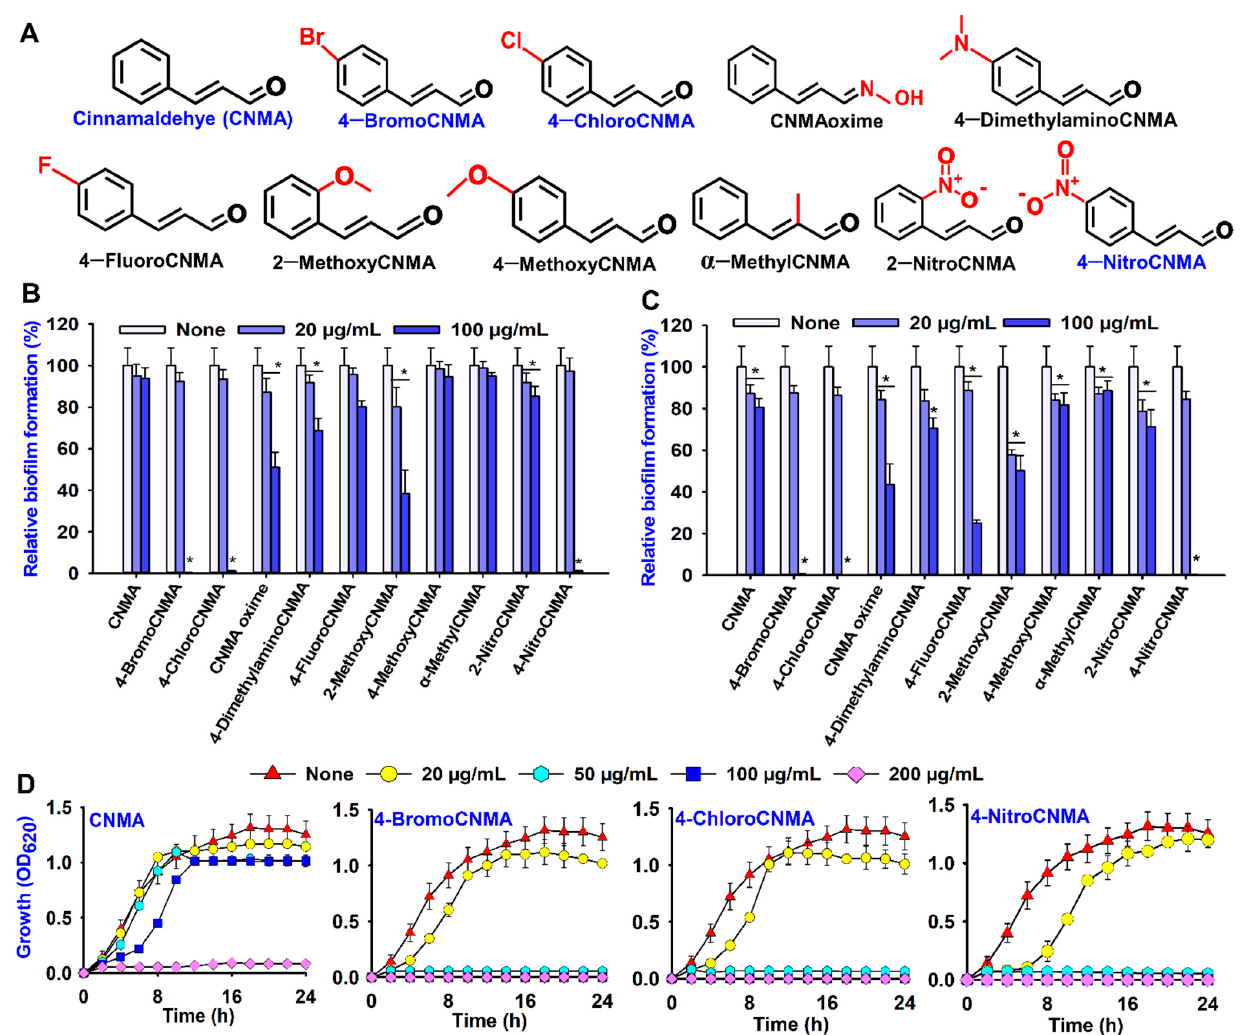
Figure 1. Structures and antibiofilm activities of cinnamaldehyde (CNMA) and its derivatives. All chemical structures ( A ), antibiofilm screening against V. parahaemolyticus ( B ), V. harveyi ( C ), growth curve of V. parahaemolyticus treated with different concentrations of CNMA and its selected derivatives ( D ). * denotes a significant difference at p < 0.05.